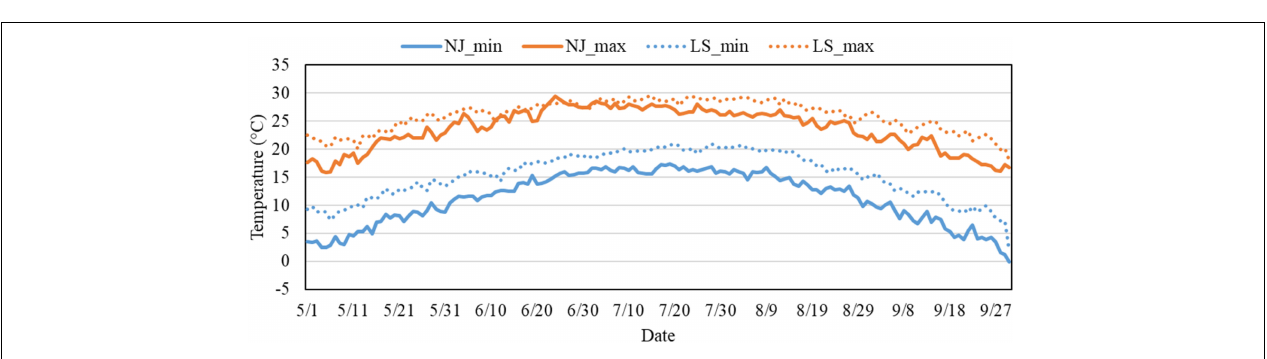
FIGURE A4 | Average temperature of the northern and southern parts of the Songnen black soil region during the recent 21-maize growth season.